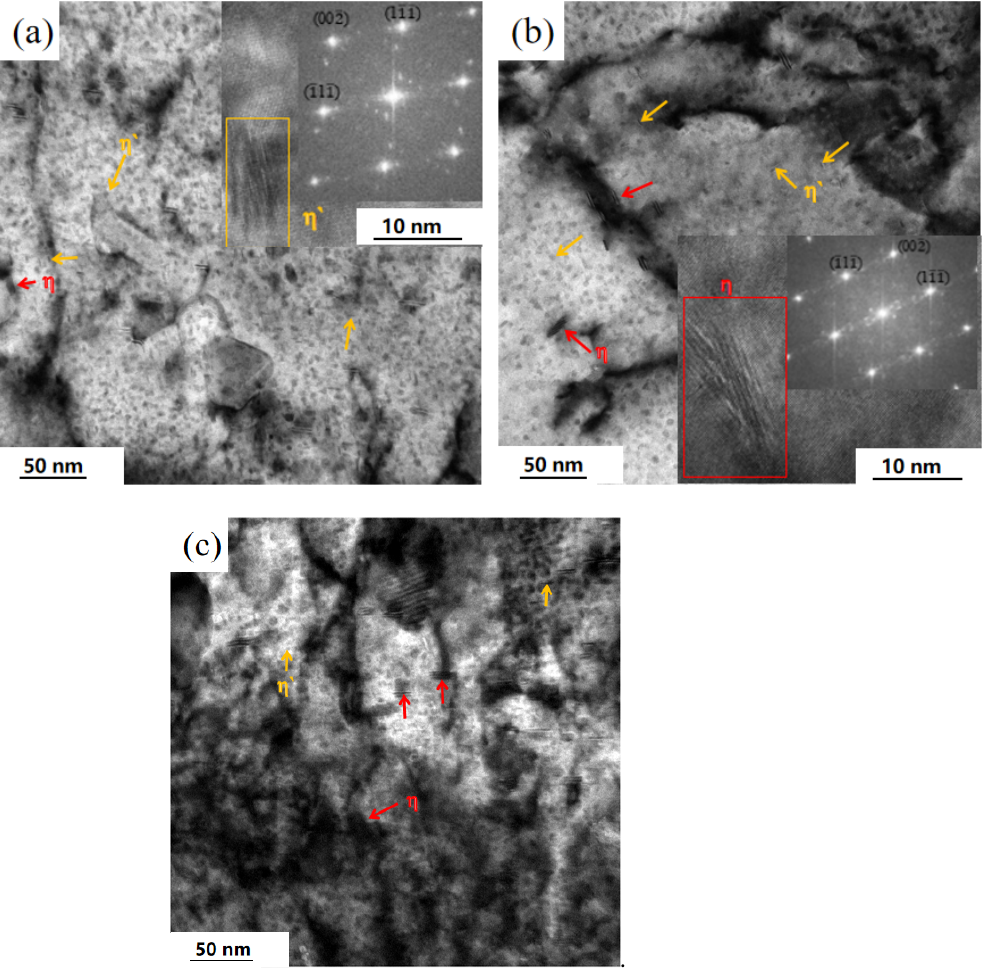
. Figure 9. TEM and HRTEM images of the 7B04-P al alloy at 140 °C during creep aging along the [110] Al Zone axis: ( a ) 4 h; ( b ) 8 h; ( c ) 12 h. [110] Al Zone axis: ( a ) 4 h; ( b ) 8 h; ( c ) 12